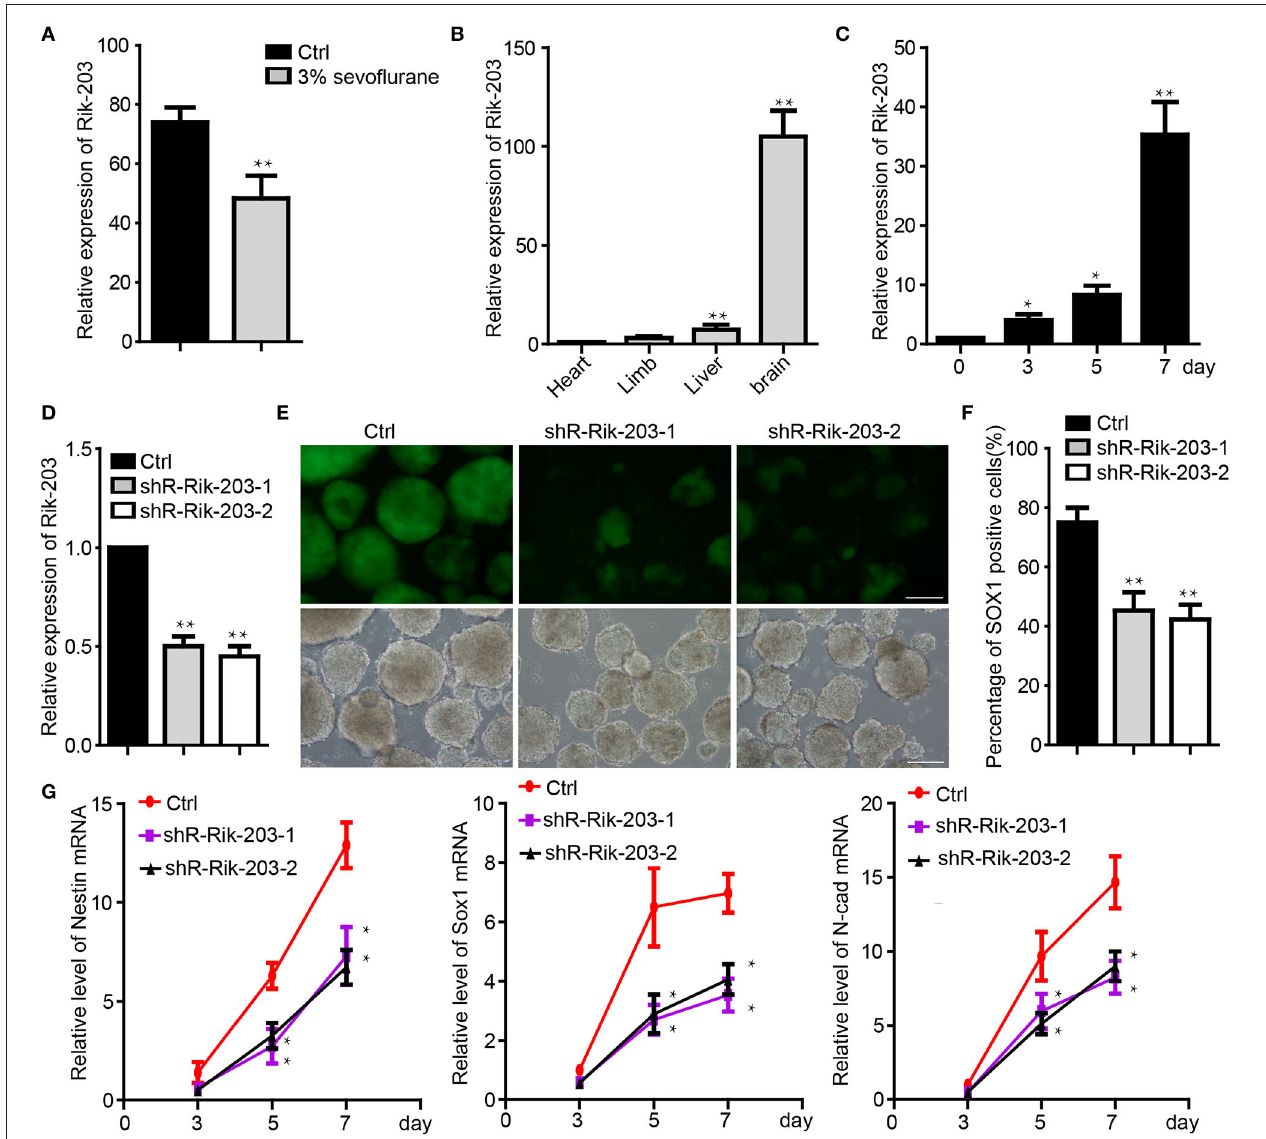
FIGURE 1 | Rik-203 regulatese neural differentiation. (A) Sevoflurane decreased the Rik-203 level in the mice hippocampus ( n = 6). (B) qRT-PCR indicated that Rik-203 level is highest in brain compared with other tissues of mice. (C) Level of Rik-203 expression during the neural differentiation from ESCs to NSCs. (D) Knockdown of the Rik-203 expression by shRNAs and repressed the neural differentiation (E) . (F) Flow cytometry assay showed the proportion of Sox1-GFP positive cells was repressed by Rik-203 knockdown. (G) qRT-PCR showed that levels of Sox1, Nestin, N-cadherin were decreased through Rik-203 knockdown. The scale bar represents 100 µ m. Ctrl means control; * p < 0.05, ** p <